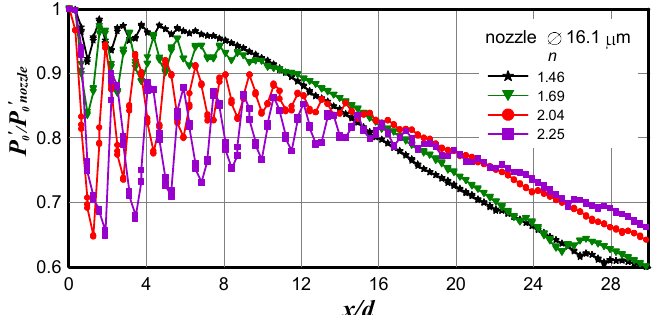
Figure 2. Axial pressure distribution measured by the Pitot tube in the jet escaping from the nozzle 16.1 µm in diameter.